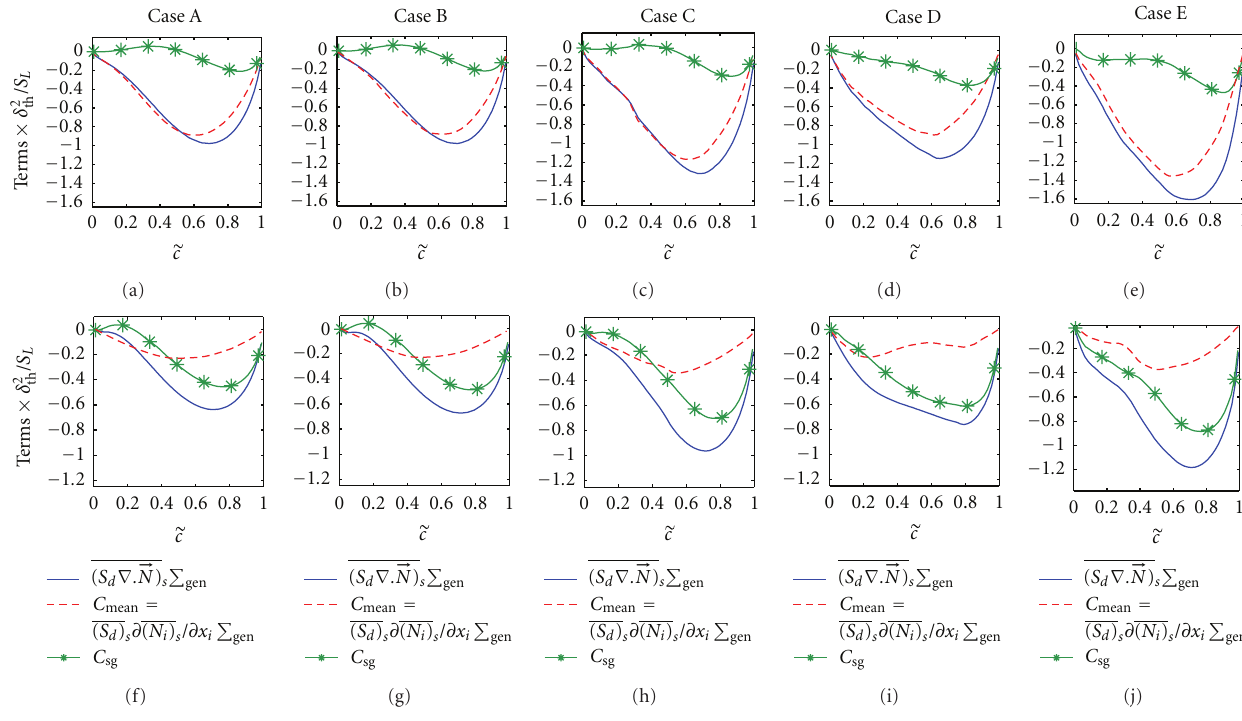
(cid:2) N Figure 2: Variations of ( S d ∇ · ) s Σ gen , C mean = ( S d ) s ∂ ( N i ) s /∂x i Σ gen and C sg conditionally averaged in bins of (cid:3) c across the flame brush for . 8 δ Δ = 24 Δ . 4 δ Δ = 8 Δ m ≈ 0 m ≈ 2 th (top row) and th (bottom row) for cases A (1st column), B (2nd column), C (3rd column), D (4th column), and E (5th column). All the curvature terms in this and subsequent figures are normalised by S L /δ 2